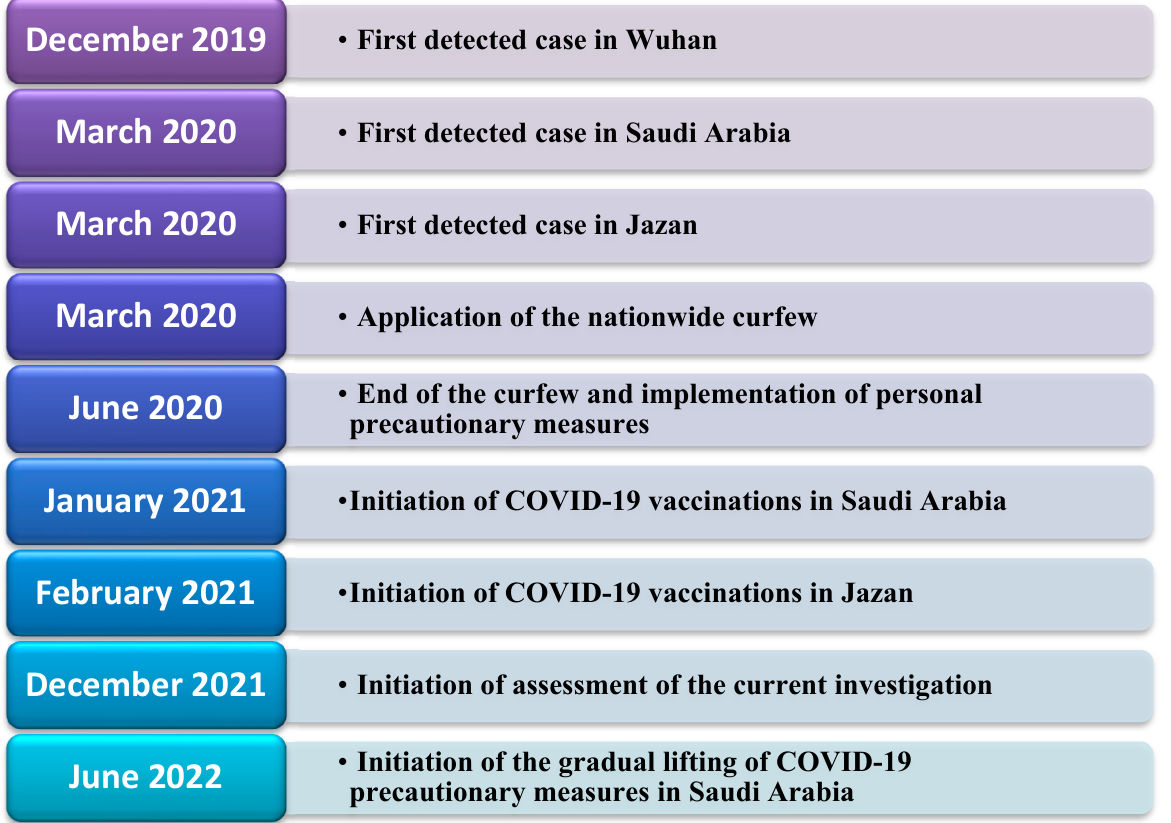
Figure 1. Timeline of COVID-19 prevention and control measures in the setting of Jazan, Saudi Arabia.